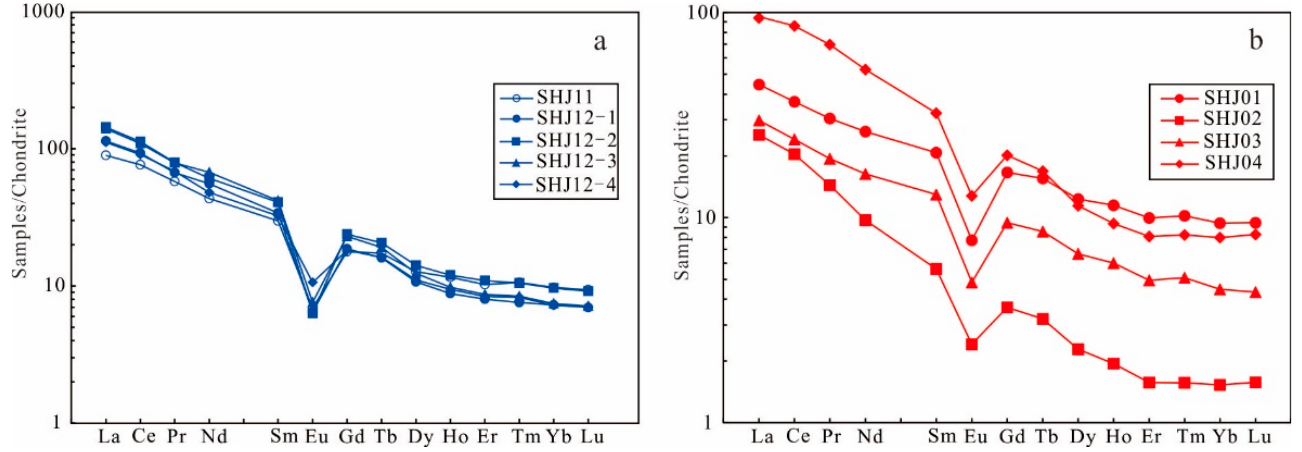
Figure 7. ( a ) Chondrite-normalized REE patterns of the Xiangcaoping granite; ( b ) fluorite of the Shuanghuajiang fluorite deposit. Table 3. Analytical data of REE (ppm) and CaO (wt%) for the Xiangcaoping granite and fluorite from the Shuanghuajiang fluorite deposit.